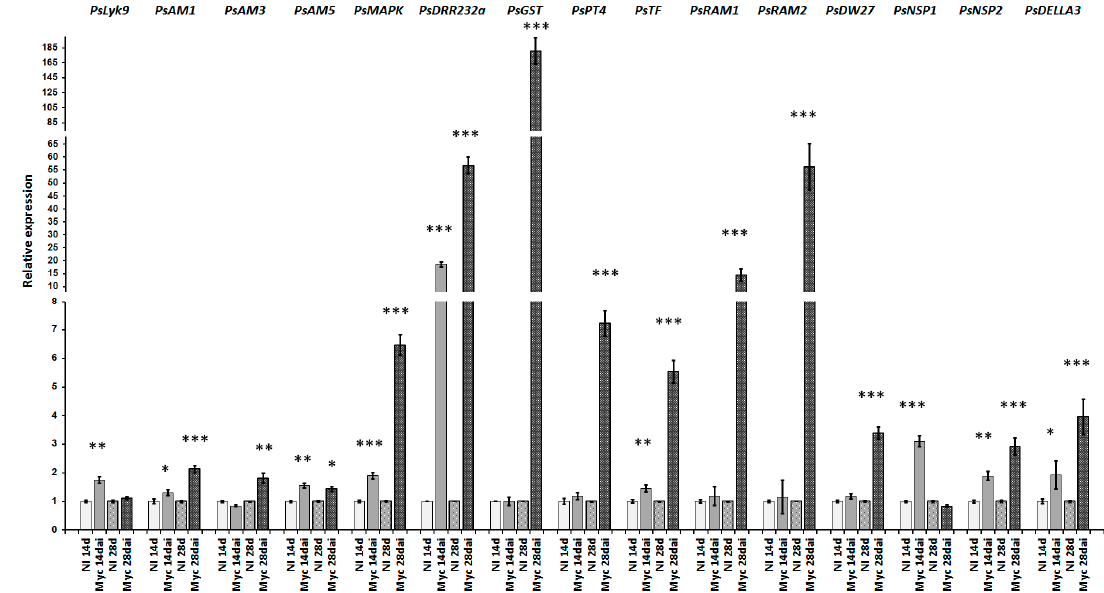
Figure 6. Up-regulation of the AM symbiosis-related marker genes in pea roots on 14 and 28 days after inoculation with R. irregularis . The relative expression was normalized against the constitutively expressed ubiquitin and actin genes. Results are means ± SEM of three technical repeats. The graphs show the results of one biological repeat, representative for three independent experiments. Asterisks indicate statistically significant differences compared with control water-treated roots: *** p < 0.001, ** p < 0.01, * p < 0.05.